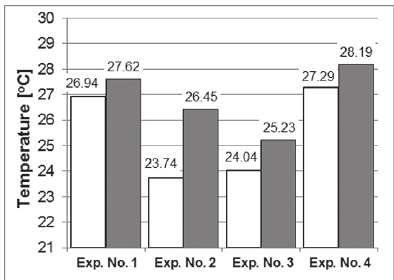
Fig. 4c. Results of calculation and measurement of average temperature of roof coating ( white – calculation, black – measured )